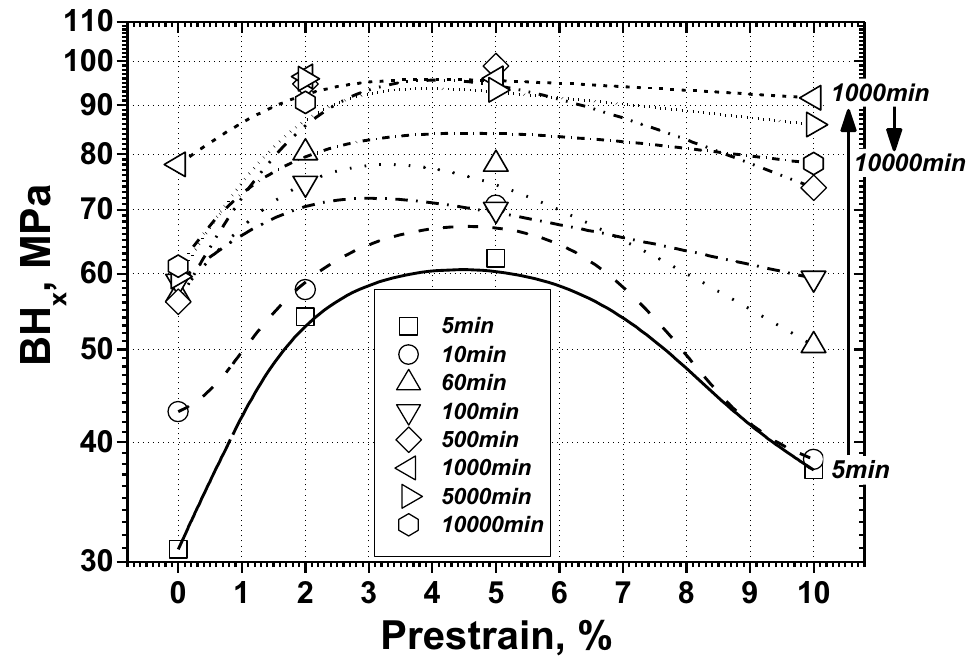
Figure 5. BH values versus prestrain for aging at 170 ◦ C from 5 to 10,000 min for the temper rolled TRIP5 steel.